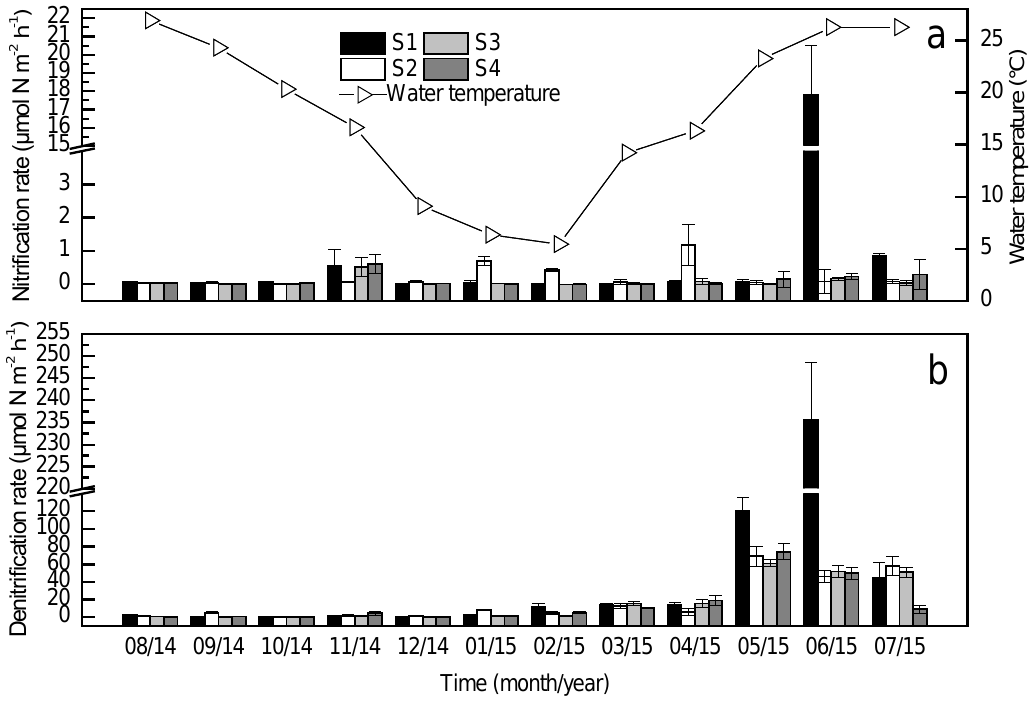
Figure 2. Monthly variations in nitrification and denitrification rates and water temperature at the sediment–water interface in Taihu Lake.